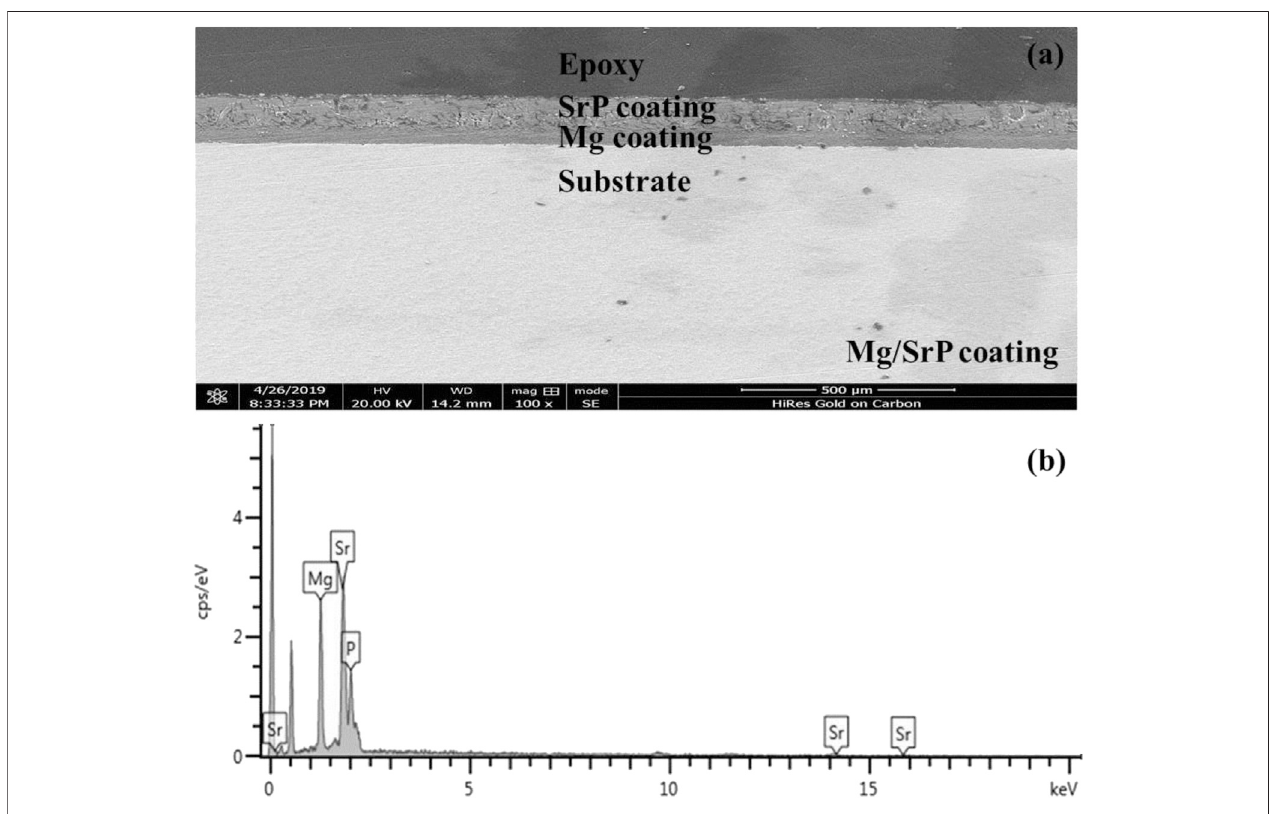
FIGURE 4 | Cross-section morphology (A) and EDS (B) results of the Mg/SrP coating.